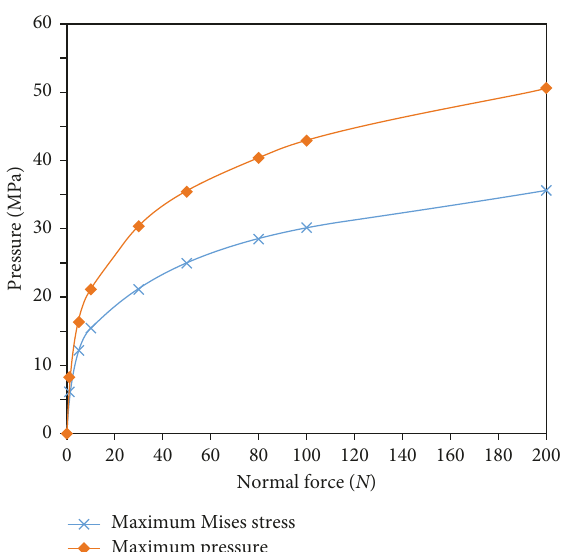
Figure 2: Contact pressure versus normal